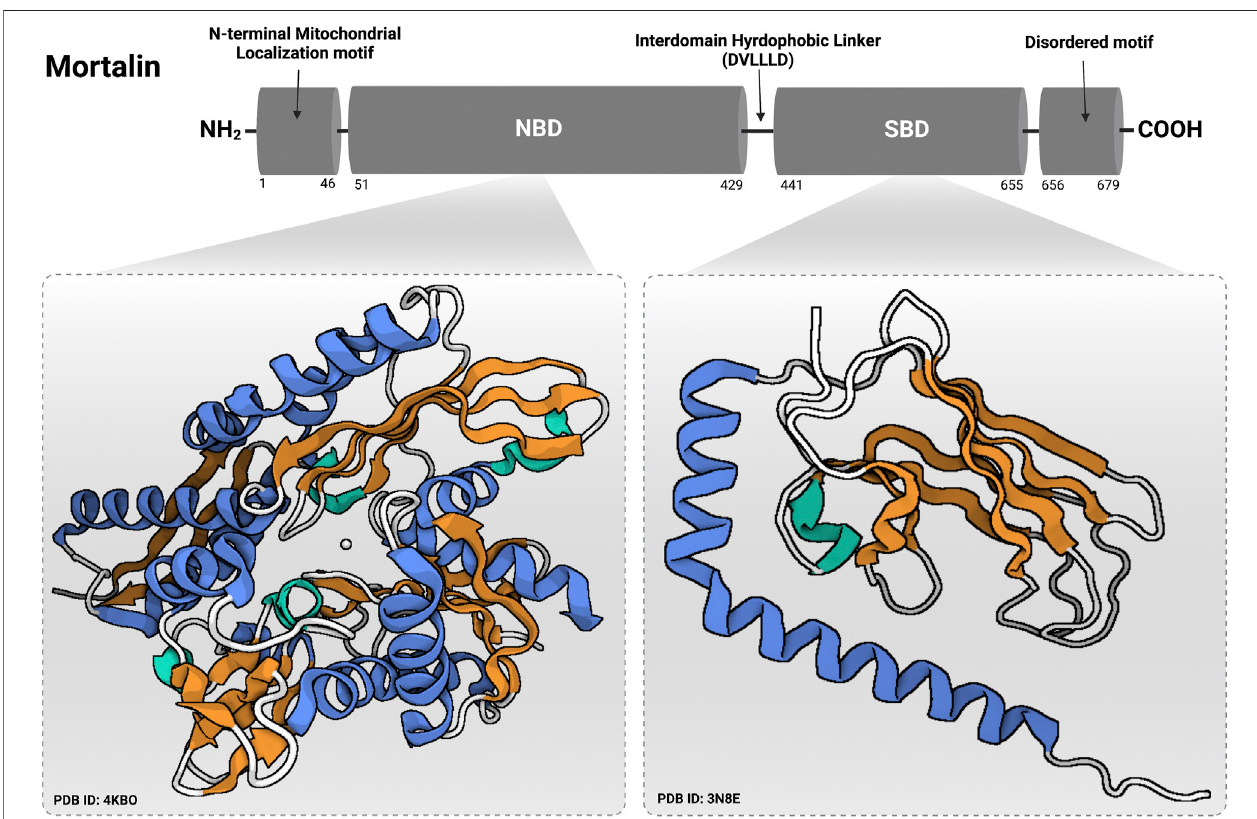
FIGURE 3 | Domain structure of mortalin. Mortalin contains an N-terminal mitochondrial localization motif followed by a nucleotide binding domain (NBD) and a substrate binding domain (SBD). NBD and SBD are connected by a hydrophobic interdomain linker (DVLLLD) (Radons, 2016). At the extreme C-terminal end, mortalin has a disordered motif. Protein Data Bank identi fi cation numbers for domain structures are given below each structure. The fi gure was created using (www.app. biorender.com).